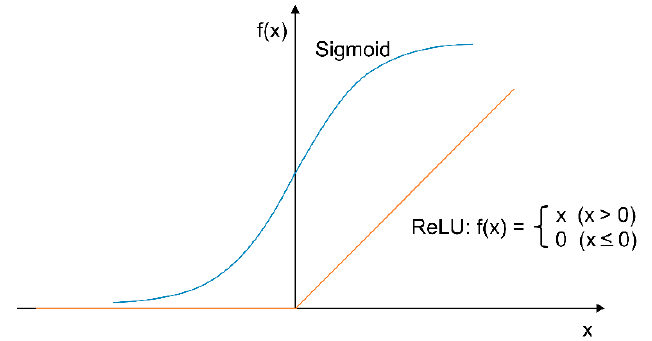
Figure 5. Comparison of the sigmoid and ReLU functions [16].